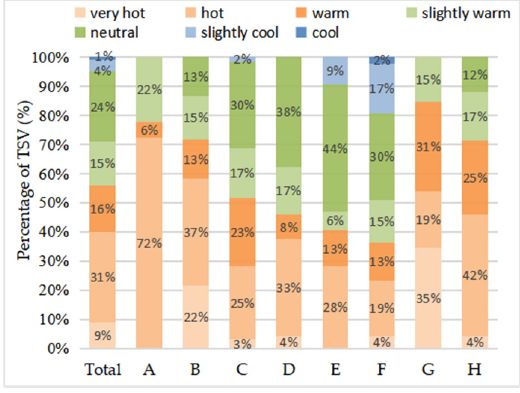
Figure 2. Percentage of TSV for the elderly in summer.